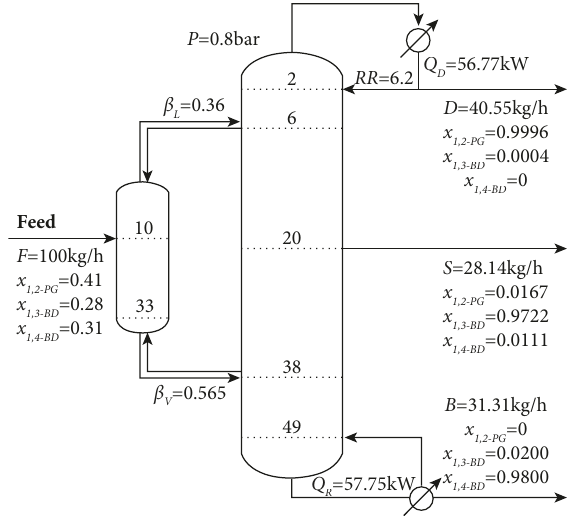
Figure 1: Two-shell configuration of the DWC. Table 1: Detailed design data of